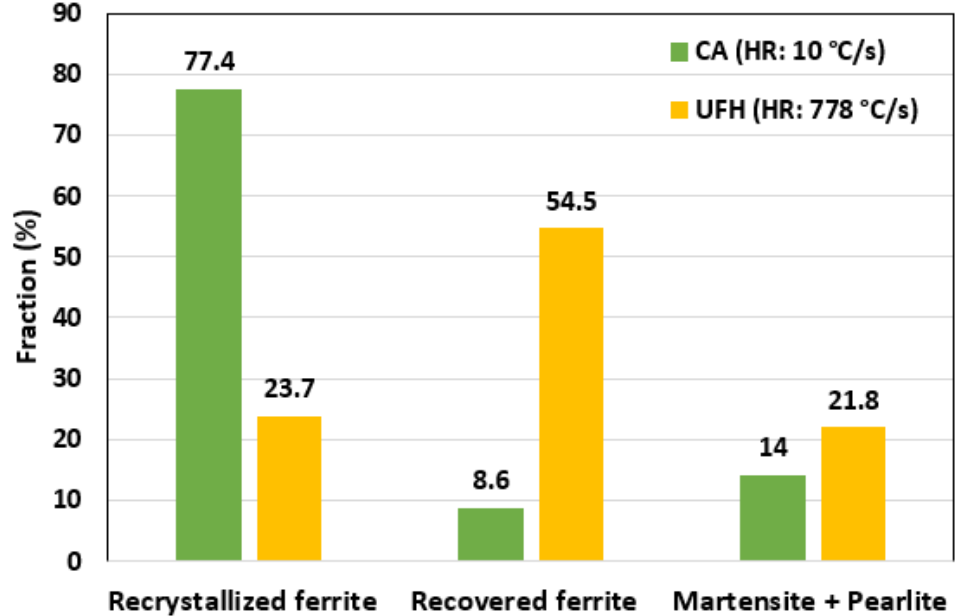
Figure 11. Microstructural evolution for CA (HR: 10 °C/s) and UFH (HR: 778 °C/s), low-carbon steel (0.14% C) (data from [43]).